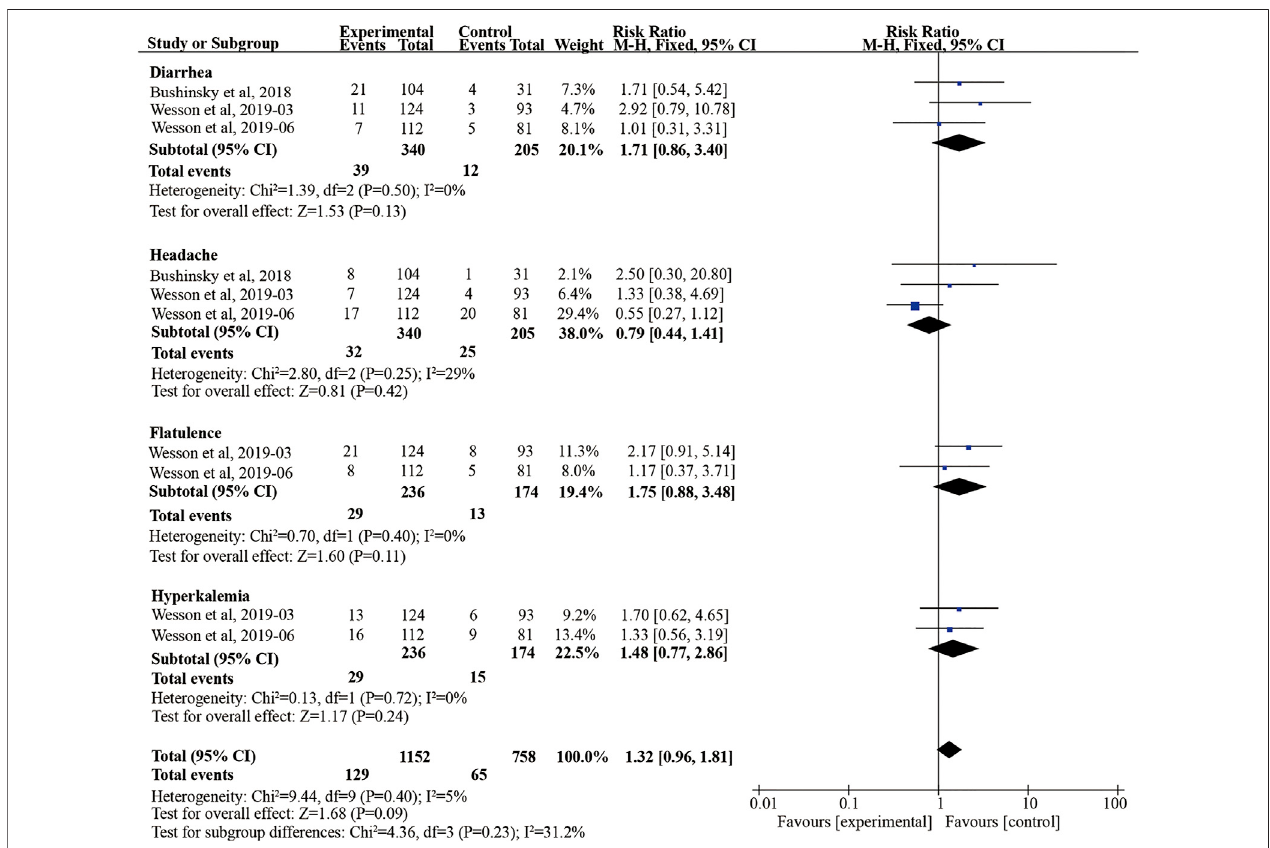
FIGURE 6 | Forest plot for safety outcomes. M-H, Mantel-Haenszel method; 95% CI, 95% con fi dence interval.